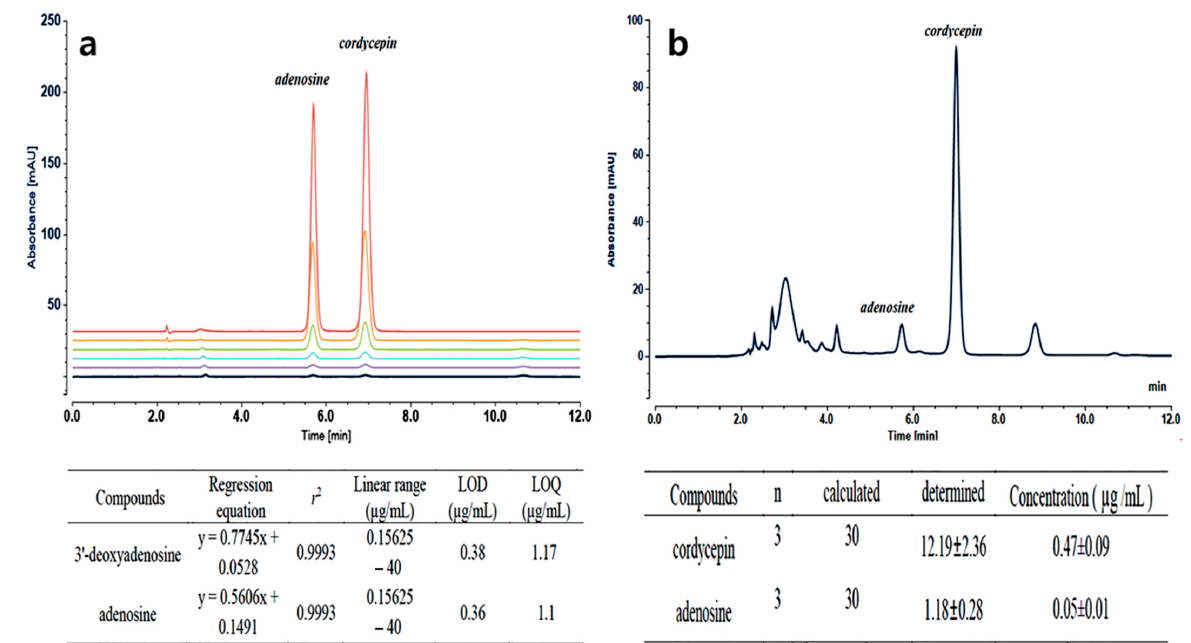
Figure 2. Determination of the cordycepin content in Cordyceps militaris extracts by high-performance liquid chromato- graphy (HPLC). Panel ( a ) showed the overlay chromatogram of various concentrations of the cordycepin and adenosine standards. Panel ( b ) showed the concentration of cordycepin in Cordyceps militaris extracts. ( p < 0.05).